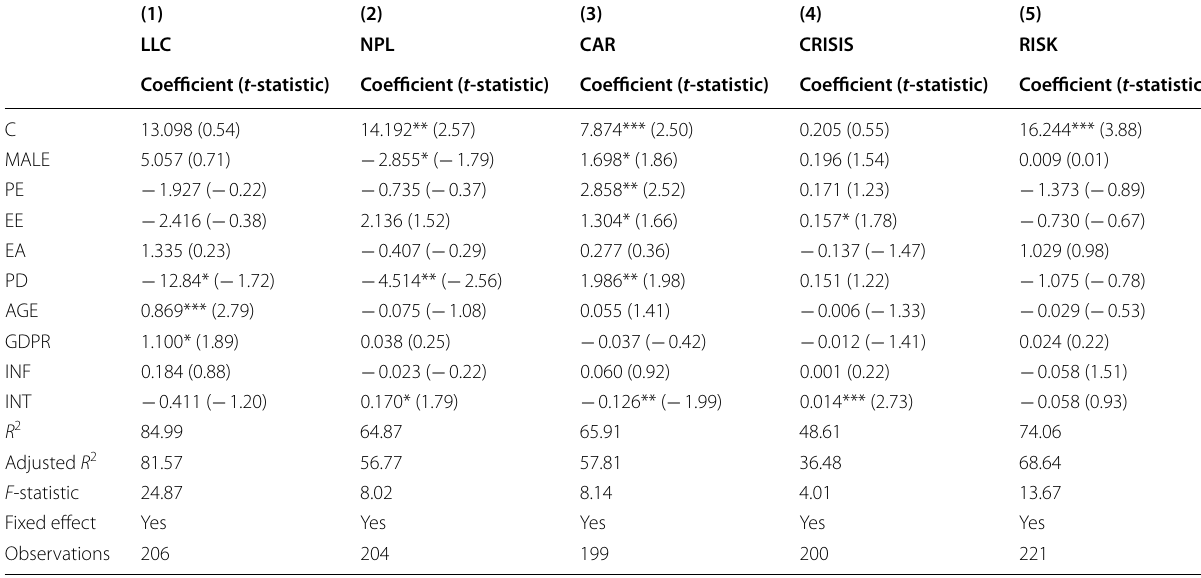
Table 3 Effect of being a male governor on financial